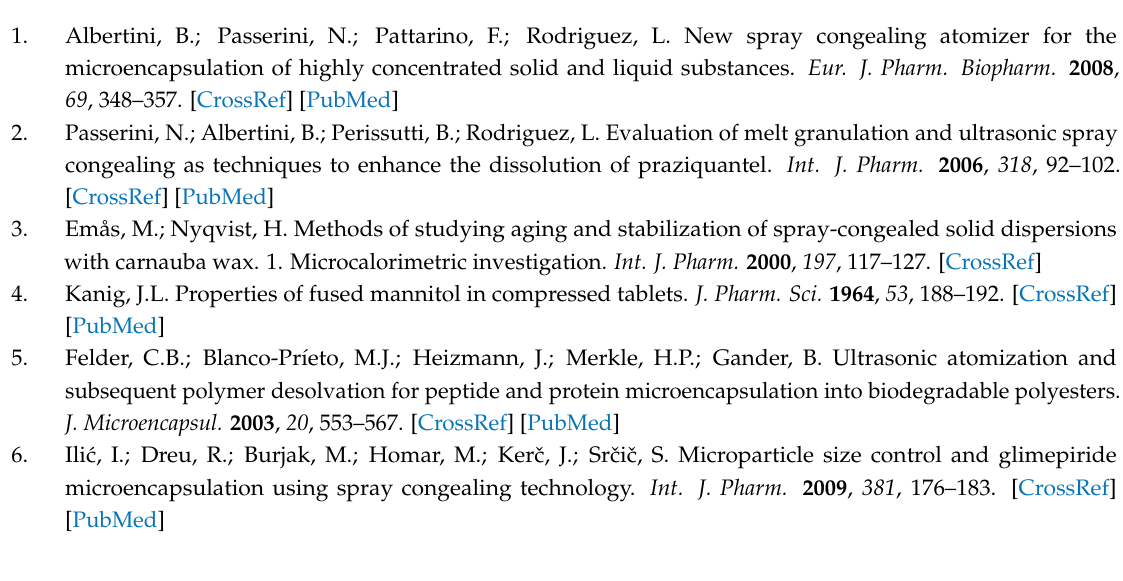
Supplementary Materials: The following are available online at www.mdpi.com/link. Figure S1: FTIR